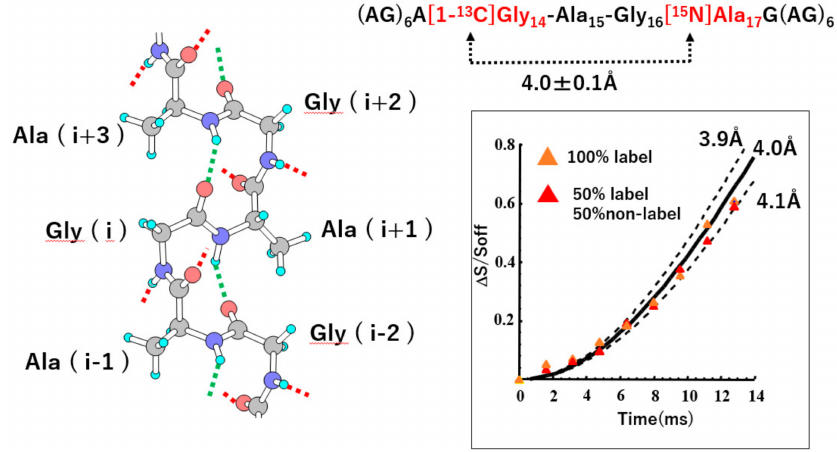
Figure 8. (Left) Picture of an isolated (AG) n chain with type II β -turn structure. (Right) Observed plots of ∆ S/S 0 (= 1 − S/S 0 ) values against the corresponding NcTr values forREDOR experiments of (AG) 6 A[1- 13 C]G 14 AG[ 15 N]A 17 G(AG) 6 to determine the distance between the [1- 13 C]Gly 14 and [ 15 N]Ala 17 nuclei. Continuous and dotted lines show the theoretical dephasing curves corresponding to the designated distances. By comparing the REDOR data and the theoretical dephasing curve, the 13 C- 15 N interatomic distance was determined to be 4.0 ± 0.1 Å. Reprinted with permission from ref. 21. Modified from ref. 21. Copyright 2001